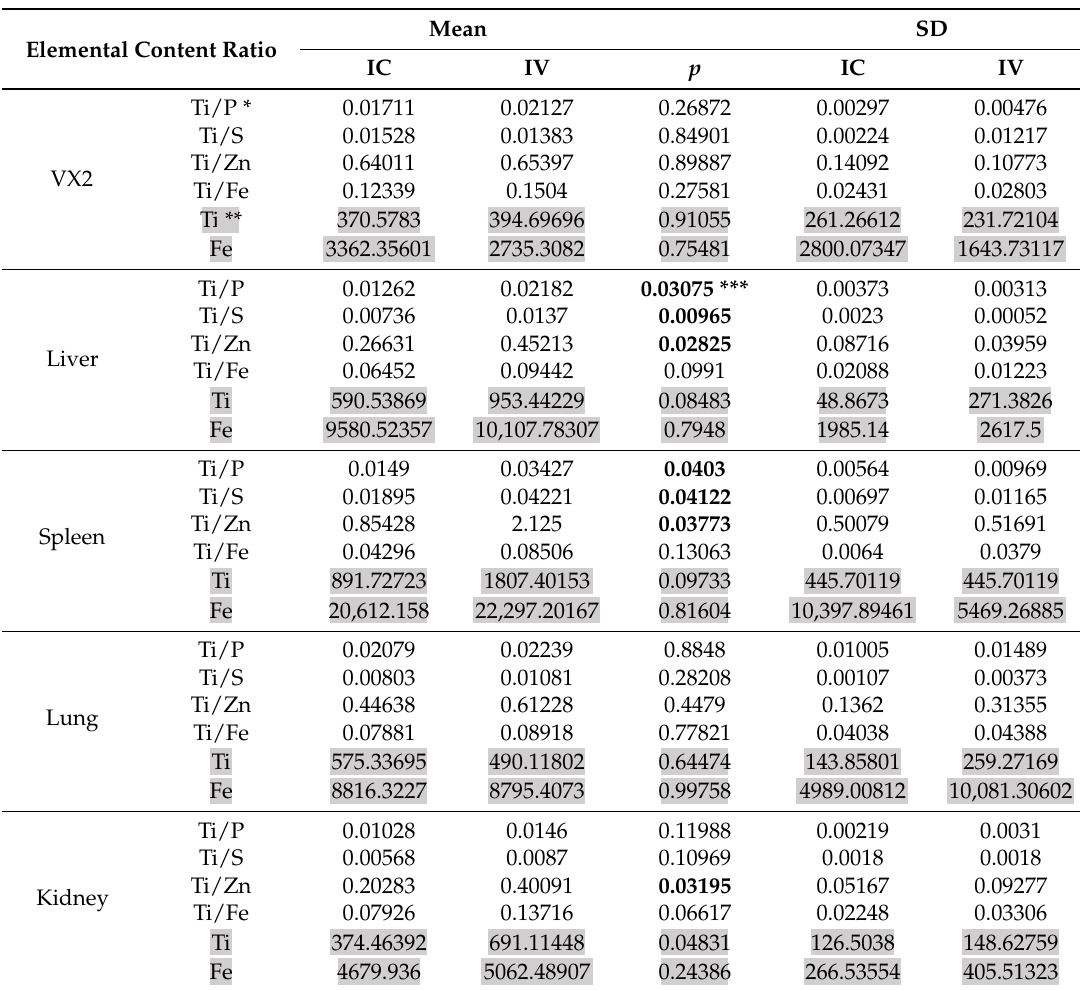
Table 1. Ratio of Ti vs. elements abundant in biological samples shows different accumulation of nanoparticles in different tissues when nanoparticle delivery by IV vs. IC is done. As a type of internal control ratio of Ti vs. Fe is shown as well. Due to the core–shell structure of nanoparticles these two elements have a constant ratio, and show no variation from sample to sample or tissue to